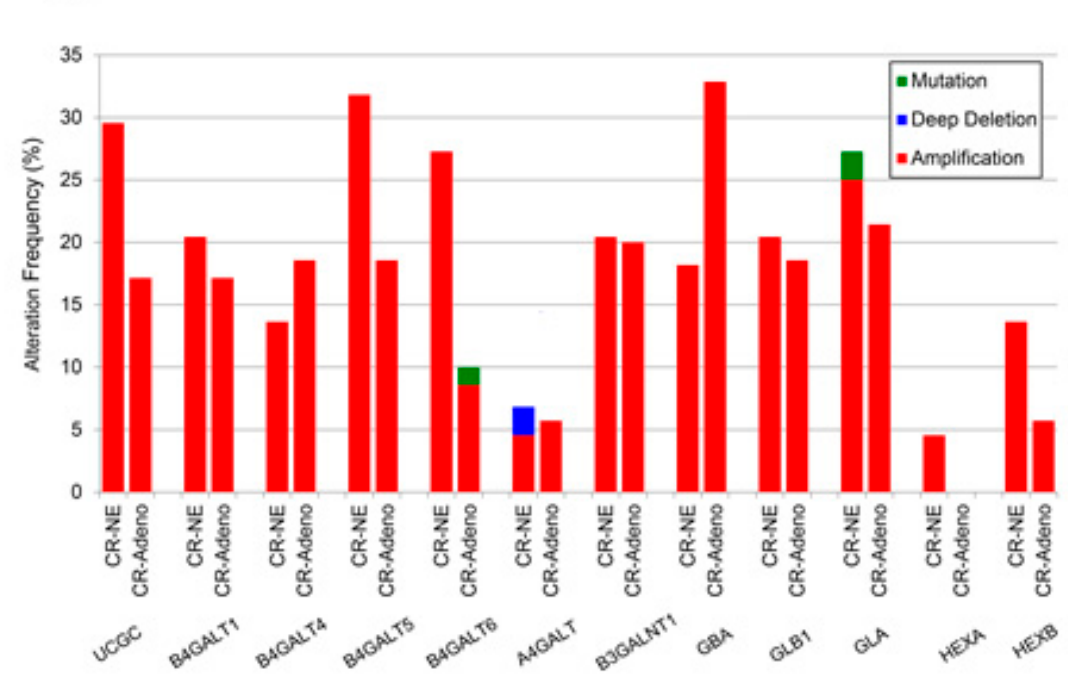
Figure 5. Analysis of changes in glycosphingolipid metabolic genes from TCGA. ( A ) TCGA data were analyzed across cancers for alterations to glycosphingolipid genes, ( B ) by anabolic and catabolic genes in PCa, and ( C ) in castration-resistant PCa.